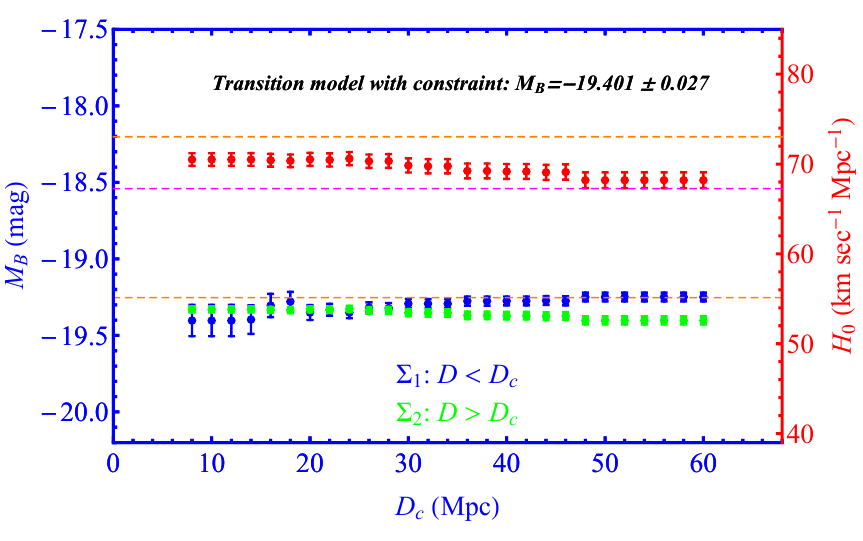
Figure 14. The new constraints on H 0 and on the parameters M < the inverse distance ladder constraint (35) on the high-distance bin of the M B transition model.